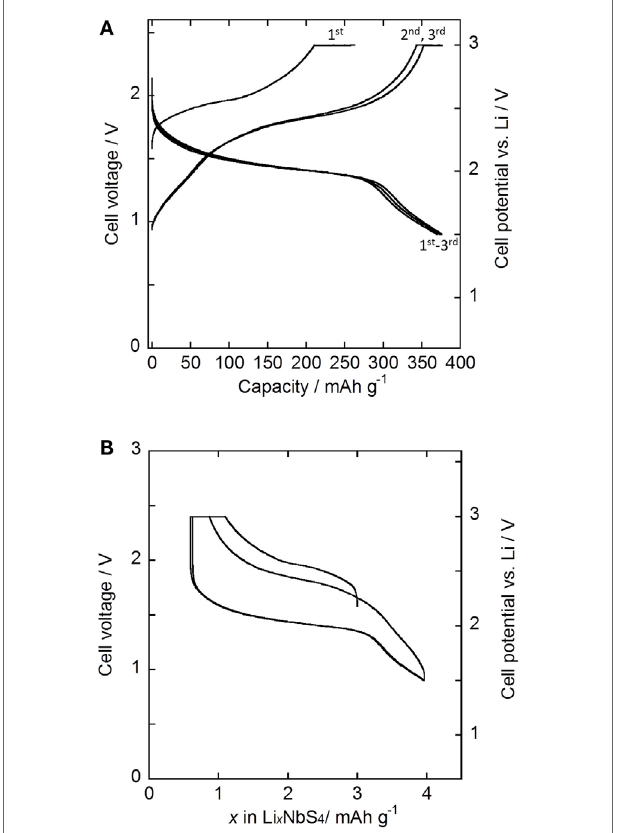
FigUre 5 | (a) Charge–discharge curves of the all-solid-state Li–In/Li 3 NbS 4 cells measured at 50°C. (B) Charge–discharge curves with the number of lithium atoms per formula unit shown on the x -axis. The current density was 0.25 mA cm − 2 , and the cutoff voltage was 0.9–2.4 V vs. Li–In electrode.